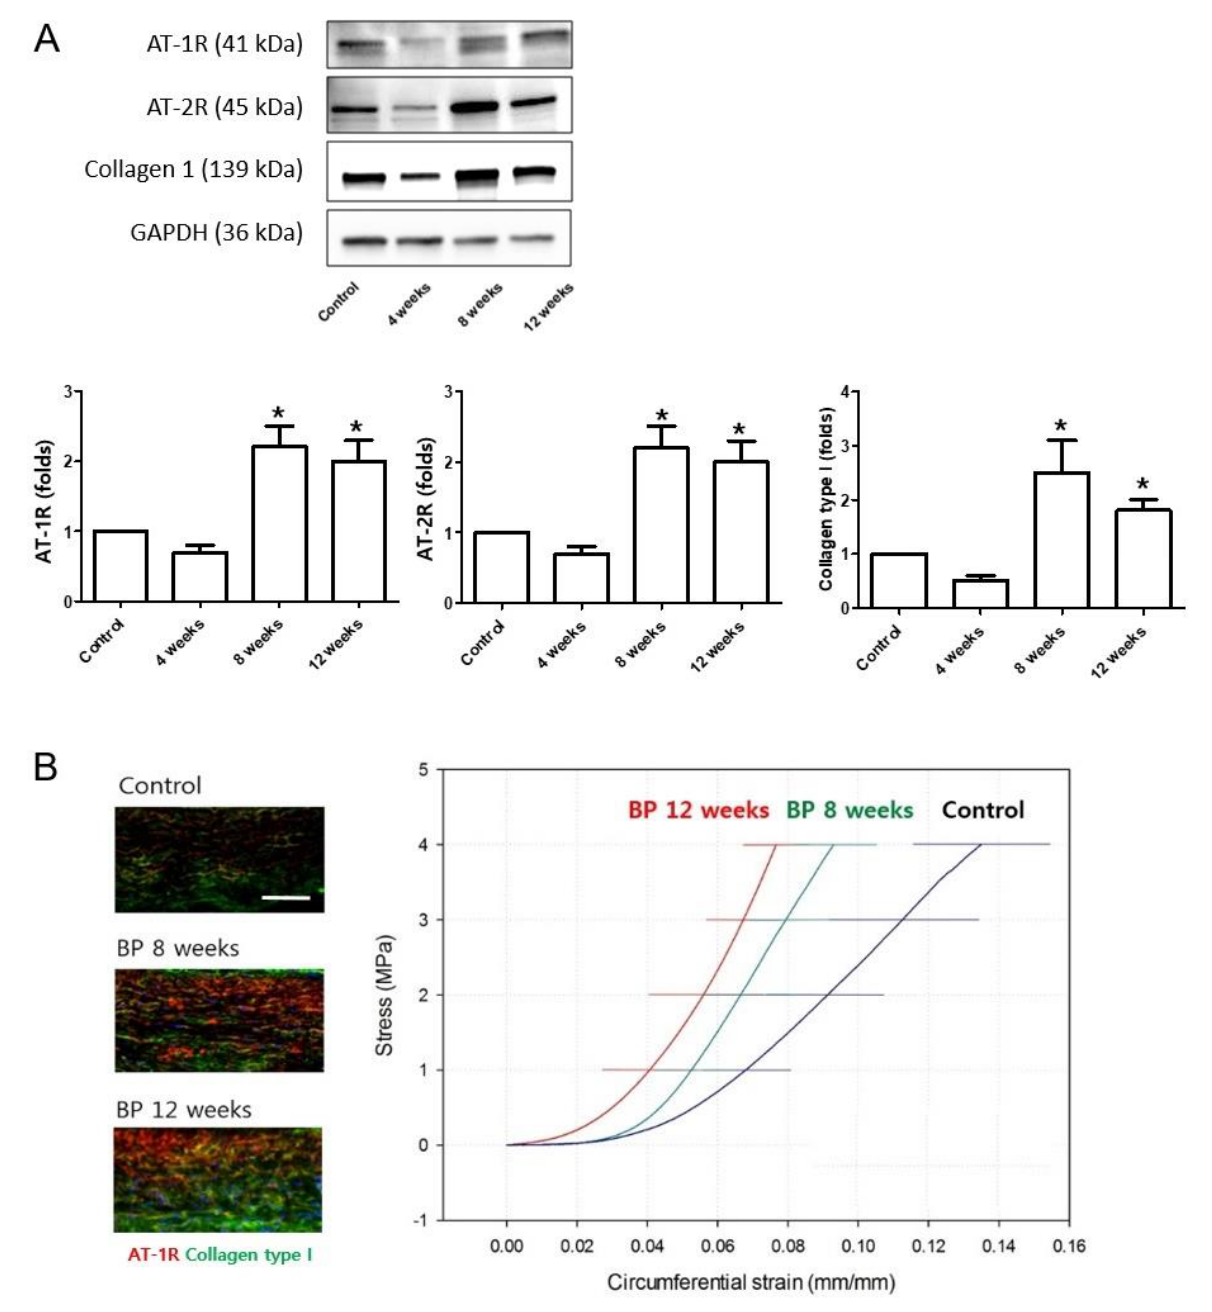
Figure 2. ( A ) Western blotting analysis of the Ang II receptors and collagen type I and the relationship between collagen type I expression and the biomechanical properties of the sclera using stress- strain analysis. Protein expression of the AngII receptors in the sclera; AT-1R and AT-2R increased significantly at 8 and 12 weeks and collagen type I increased at 8 weeks after systemic hypotension. * p < 0.05 compared to the control. ( B ) The stress–strain curves in the clinical range of IOP were obtained using scleral strip specimens. As the duration of systemic hypotension was extended, the sclera experienced less strain, indicating less tissue deformation or stiffened tissue under the same load. The decrease in strain was accompanied by increased expression of AT-1R and collagen type I. For stress–strain analysis, n = 6 for control and n = 6 for systemic hypotension at each time period; total n = 24; Scale bar = 10 µ m. The bar represents mean ±